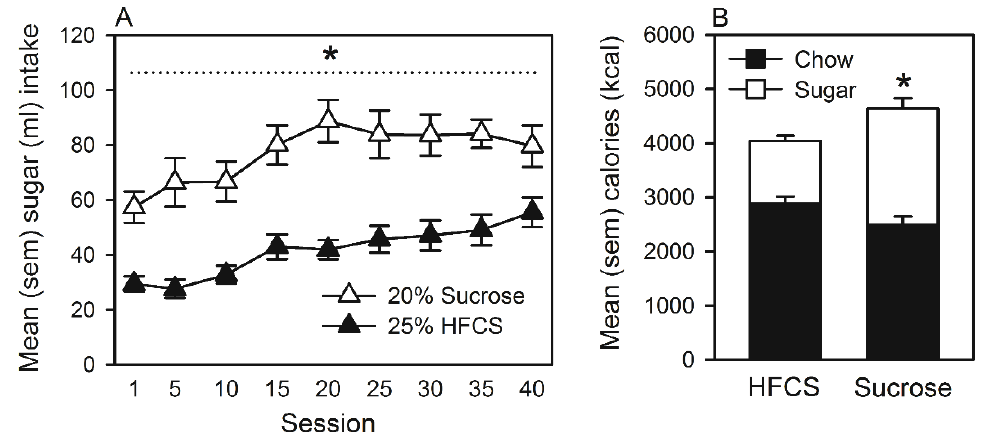
Figure 6. ( A ) Mean (SEM) sugar (mL) intake by rats that self-administered 25% HFCS or 20% sucrose in their home cages. * Significant difference between groups. ( B ) Mean (SEM) total calories (kcal) consumed by rats. The proportions of calories derived from chow and sugar consumption are represented by the black and white stacked bars, respectively. * Significant difference in total caloric intake between the 25% HFCS and 20% sucrose groups.